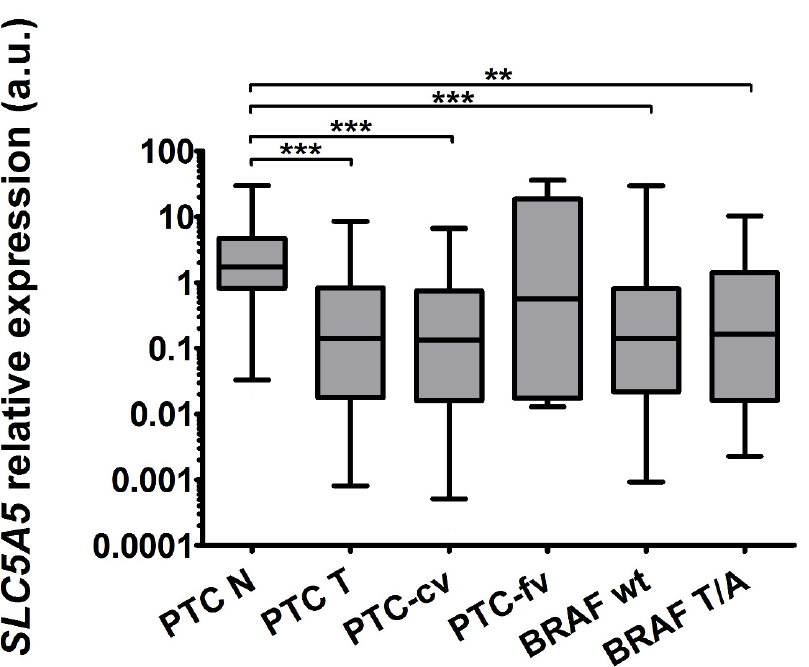
Figure 1. The expression of SLC5A5 was 12.27-fold ( p < 0.0001) reduced in PTC (PTC-T, n = 49) compared with normal adjacent tissue (PTC-N, n = 49). The reduction was more profound in the classic variant of PTC (PTC-cv, n = 44, 13.16-fold, p < 0.0001) compared with the follicular variant (PTC-fv, n = 5, 3.11-fold, non-significant). The reduction was observed both in the BRAF wild-type group (BRAF wt, n = 23, 12.27-fold, p = 0.0009) and BRAF mutated group (BRAF T/A, n = 18, 10.65-fold, p = 0.007; please note that expression in tumors was compared with expression in matched controls only). The graph shows the expression of SLC5A5 in thyroid tissue samples normalized against HPRT . Data are expressed as median, interquartile range and 5–95 percentile. Statistical analysis was performed with a Mann–Whitney U test (** p < 0.01, *** p < 0.001). Logarithmic scale was used.